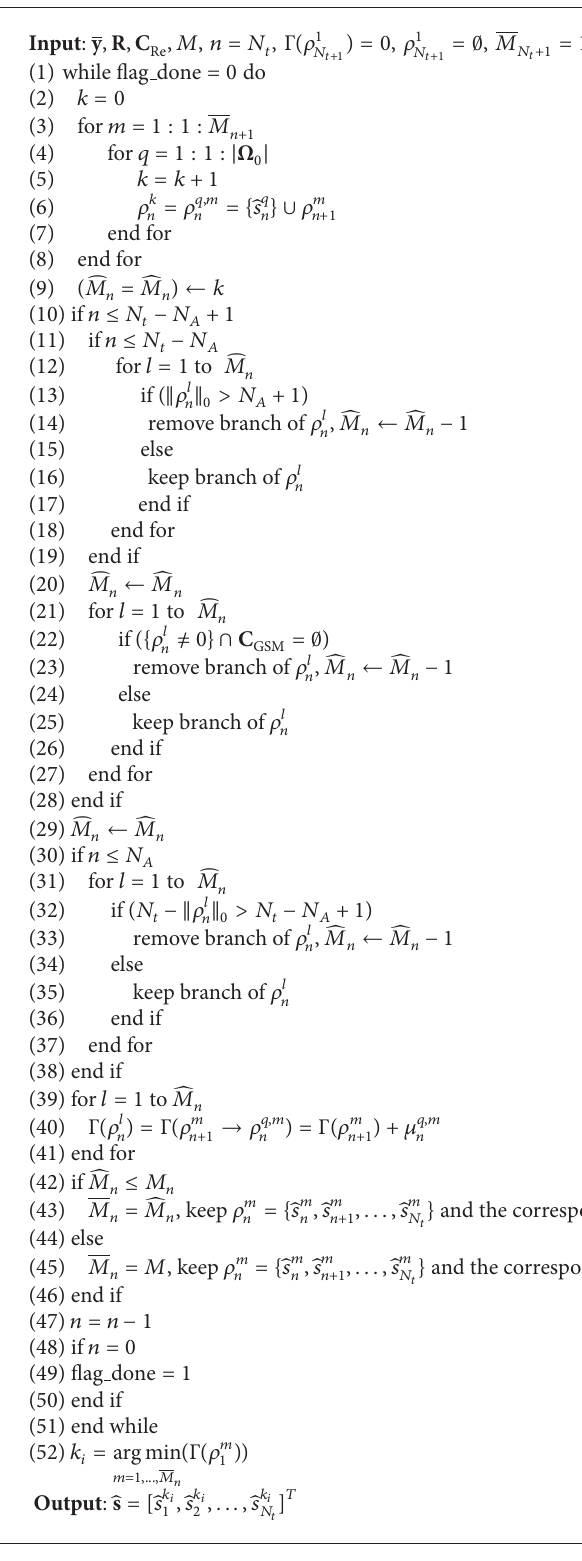
Pseudocode 1: The pseudocode of the improved QRD-M algorithm for GSM